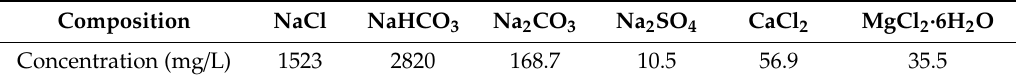
Table 1. Composition of mineralized